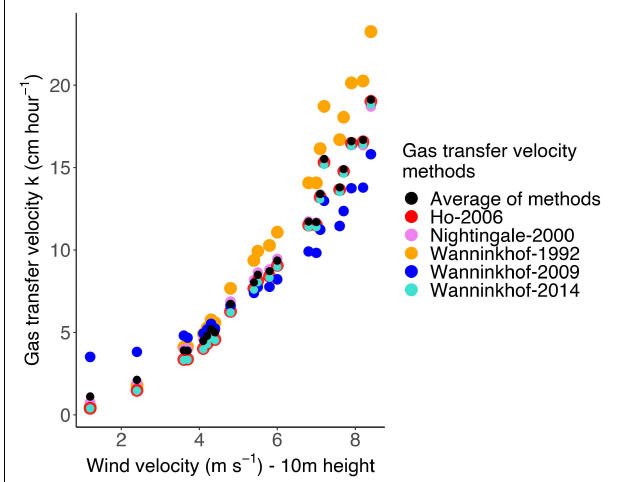
FIGURE 2 | Relationship between gas transfer velocity and wind velocity at 10 m height for five different gas transfer models and the corresponding mean. The relationship by Wanninkhof (2014) was used in this